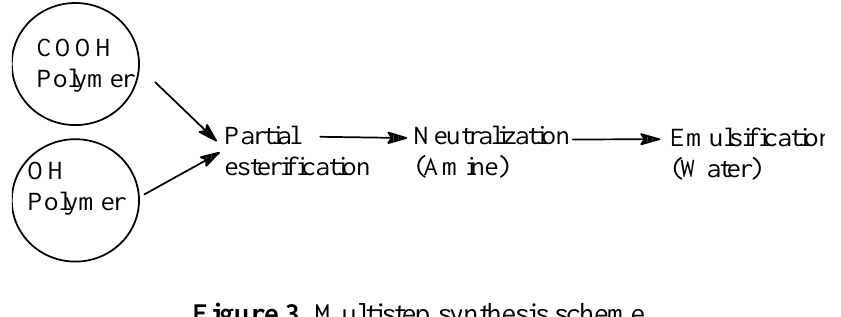
Figure 3 . Multistep synthesis